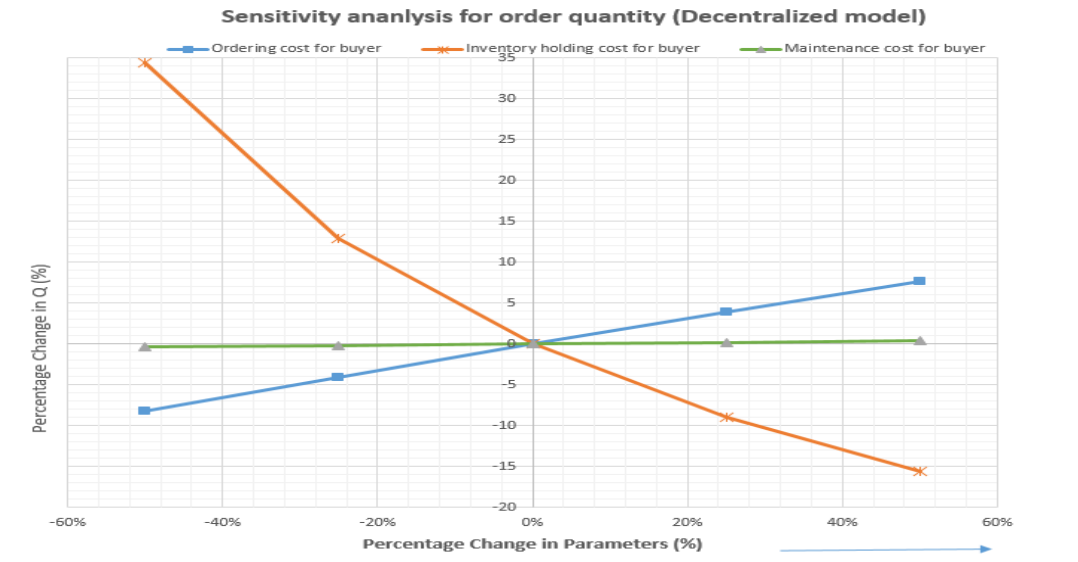
Figure 8. Sensitivity analysis: order quantity (Q) versus change in parameters under decentralized model.